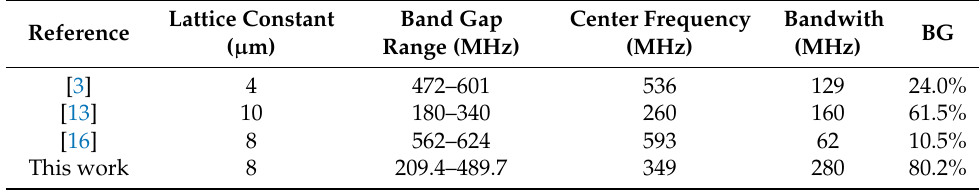
Table 2. Band gap comparison of similar lattice constants.